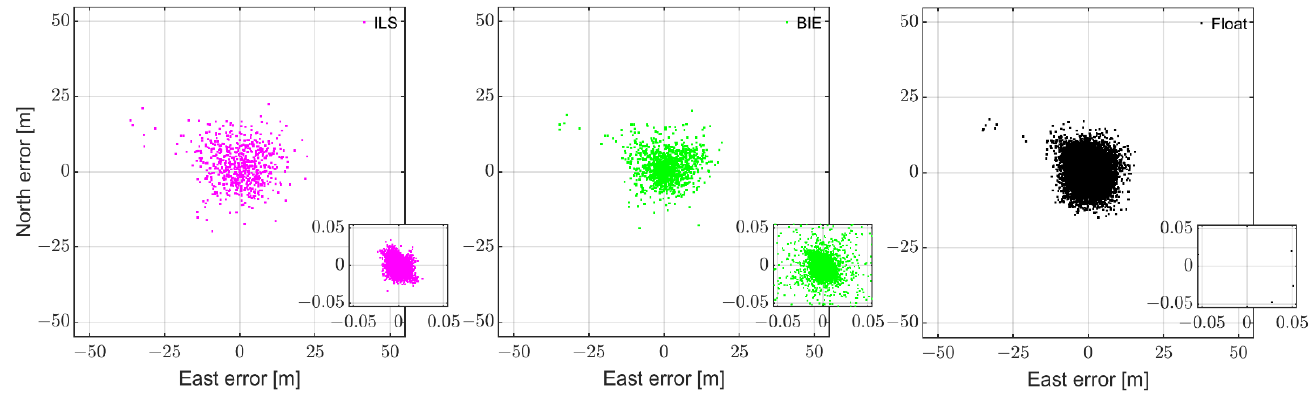
Figure 5. The 95.4% ILS SR scenario (see Figure 4f): horizontal (north/east) scatter plot of the multi- GNSS, dual-frequency (L1 + L5 GPS, E1 + E5a Galileo, L1 + L5 QZSS, and B1 BDS) GP4 data derived with the ILS (left column), BIE (middle column), and ambiguity float (right column) estimators for instantaneous RTK positioning with smartphone internal antennas.